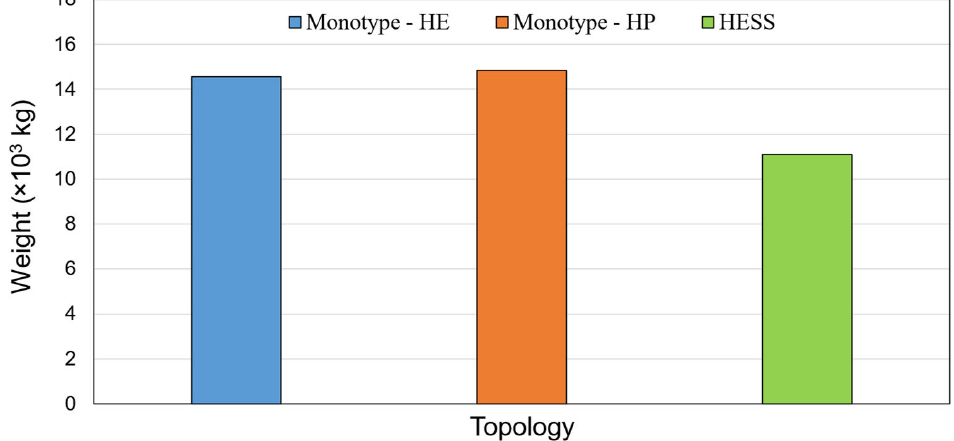
Figure 12, battery hybridization can significantly reduce the total weight of the battery cells. The highest weight corresponds to the monotype HP system, followed by the monotype HE system and HESS. The weight of the HE monotype battery is 2.3% lower than the HP monotype, while the weight of the HESS is 33.5% lower than the HP monotype system.